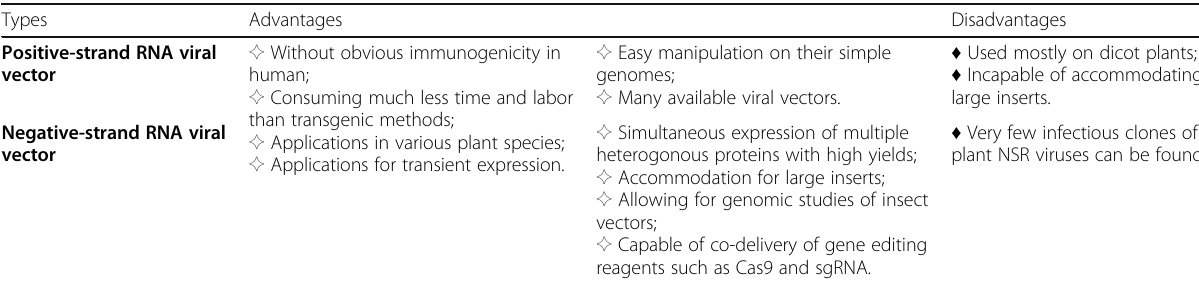
Table 1 Advantages and disadvantages of plant positive-strand and negative-strand RNA virus-based